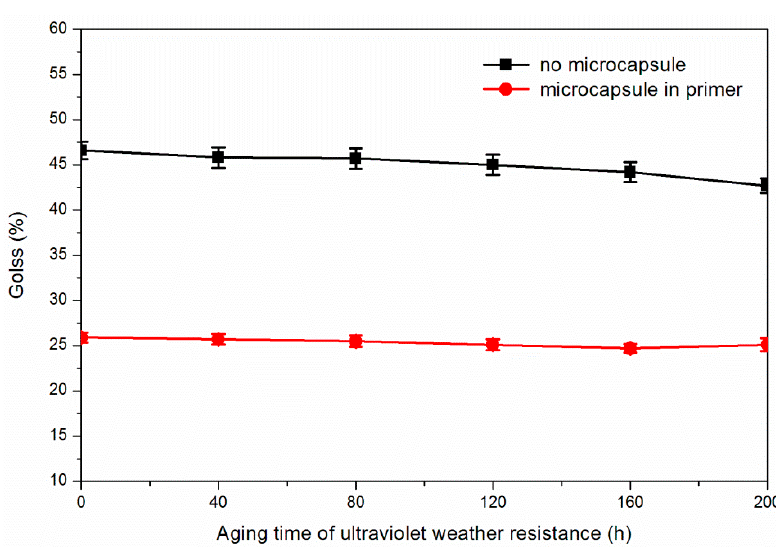
Figure 10. E ff ect of aging time on gloss of the paint film in the 160 ◦ C oven. Figure 10. Effect of aging time on gloss of the paint film in the 160 °C oven.